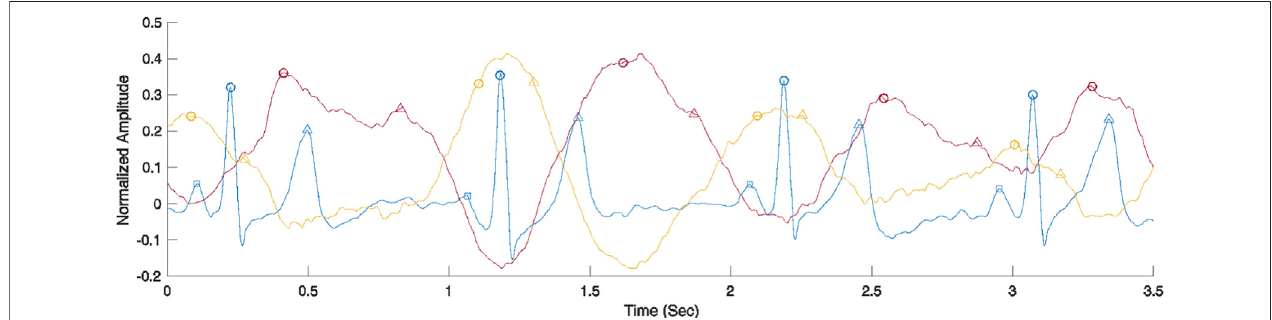
FIGURE 9 | Comparison of ECG (blue) and SRVI signals (carotid artery signal in red and JV pulse signal in yellow). ECG landmarks are P-waves representing maximal atrial depolarization (squares), R-peaks representing maximal ventricular depolarization (circles) and T-wave representing maximal ventricular repolarization (triangles). The carotid artery SRVI landmarks are systolic peaks (circles) and estimated diastolic peaks (triangles). The JV pulse SRVI landmarks are a-waves representing atrial contraction (circles) and c-waves representing right ventricular contraction